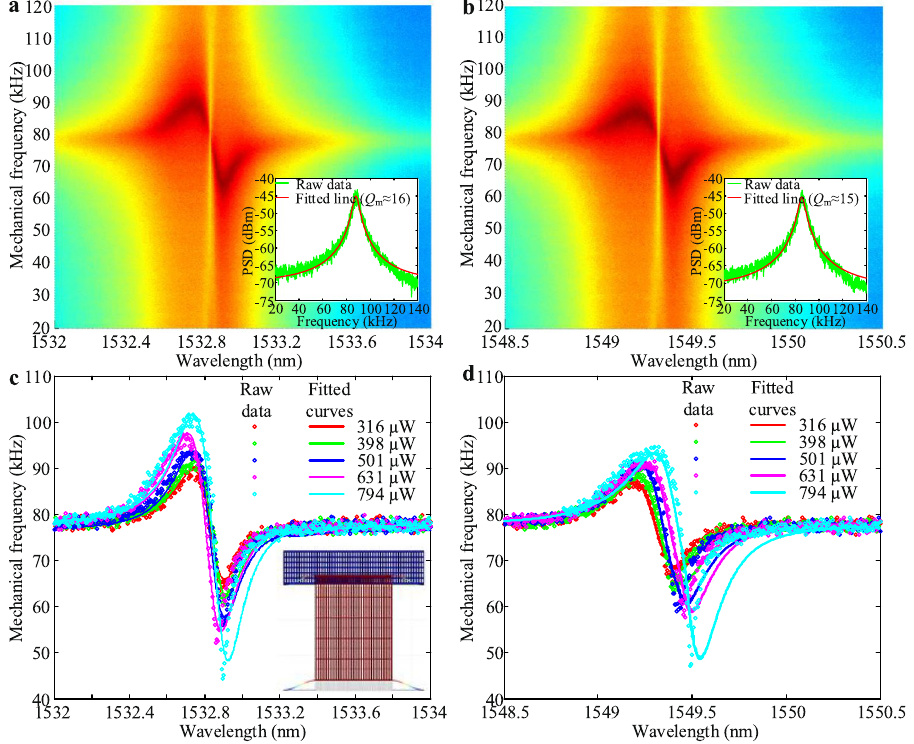
Figure 3. Mechanical frequency stiffening versus different optical detunings at various input powers. ( a ) and ( b ) The two-dimensional mapping plots for the mechanical frequency stiffening versus different optical detunings for mode 1 and mode 2, respectively. The drive power here is 316 μ W. The insets are the power spectrum density (PSD) at blue detuning side ( ≈ 1532.65 nm and ≈ 1549.19 nm for the two optical modes). ( c and d ) The peak mechanical frequency shifts for different input powers. The solid lines are the fitted data for determining the optomechanical coupling ( g om ) with the optomechanical stiffening relation. The g om for both modes are obtained as ≈ 43.9 GHz/nm and 49.8 GHz/nm,